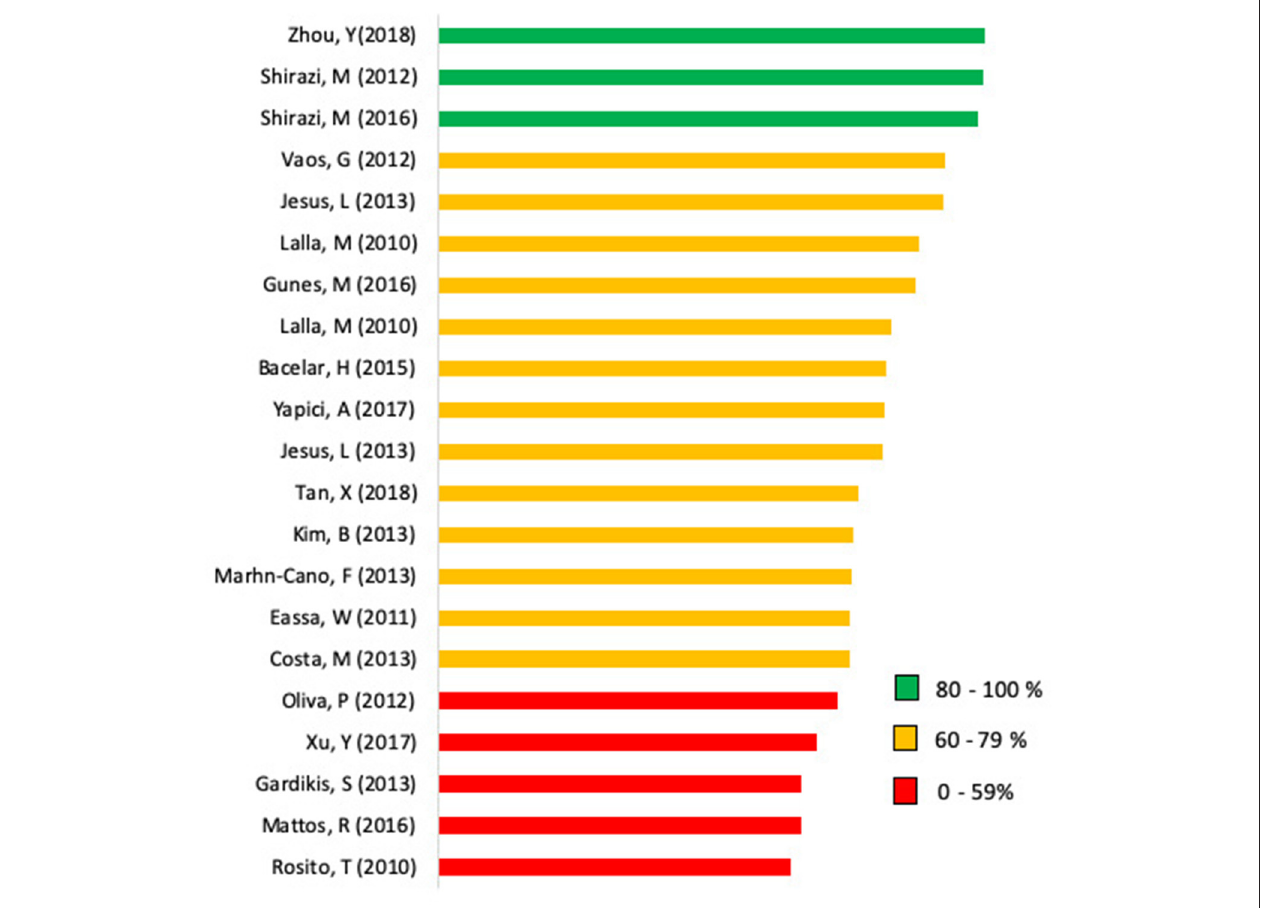
FIGURE 3 | Bar chart displaying the scores of the analyzed articles. Scores represent the percentage adherence to the ARRIVE (Animal Research: Reporting of In vivo Experiments) guidelines on a scale from 0 to